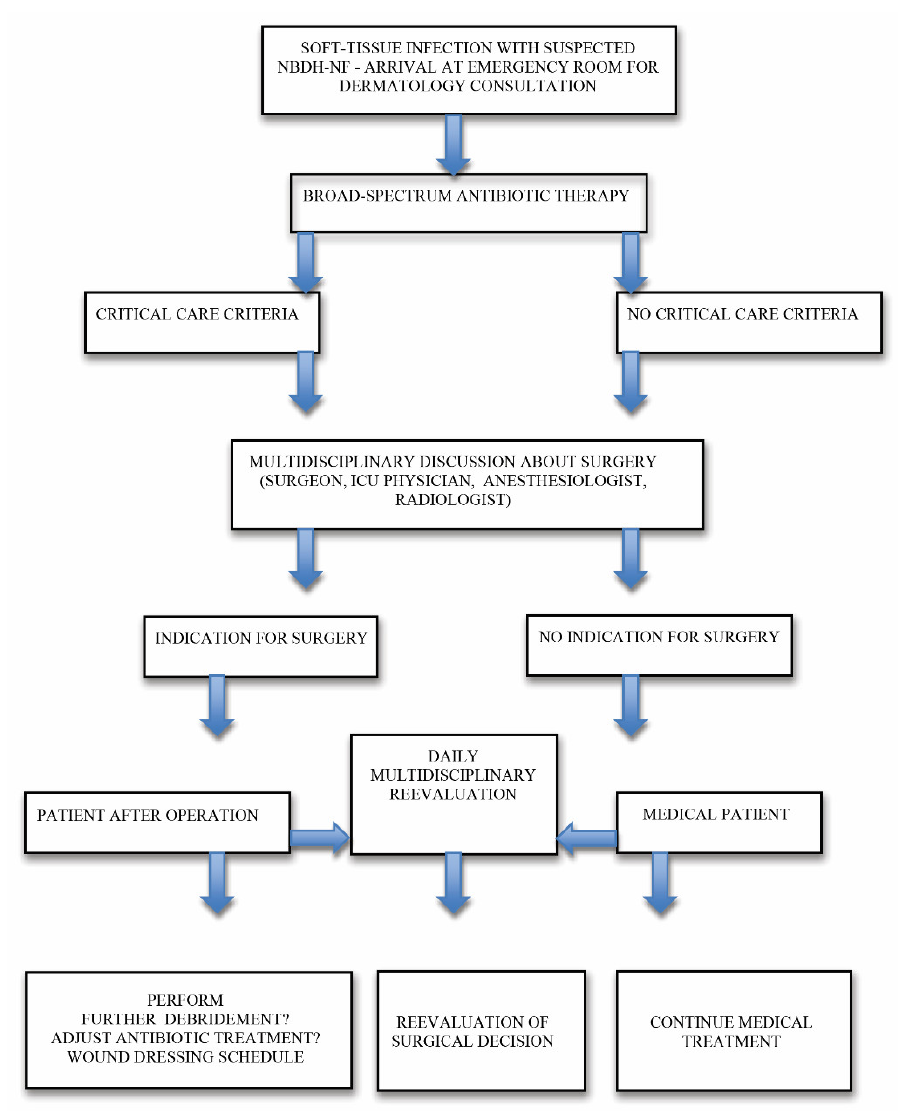
Figure 1. Authors’ algorithm for upper limb NF management.